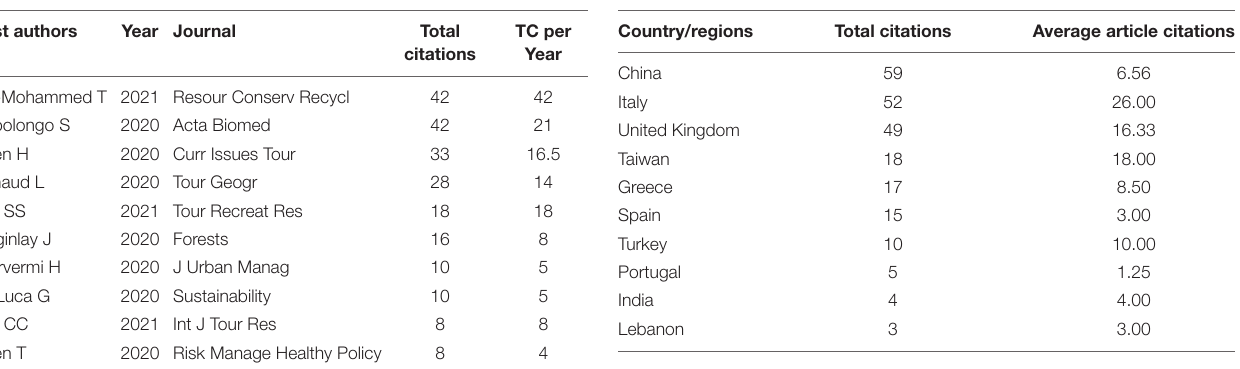
TABLE 9 | Top publications with citations. TABLE 10 | Top countries/regions in